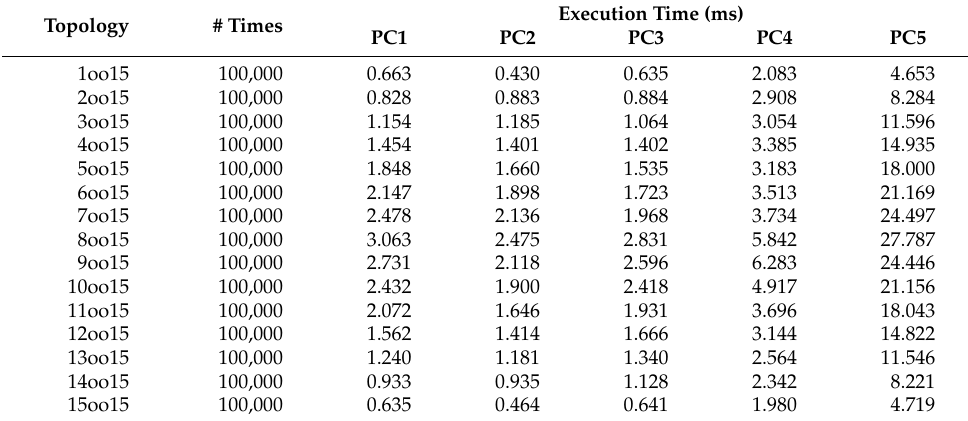
Table 12. Performance evaluation of K oo15 identical block.